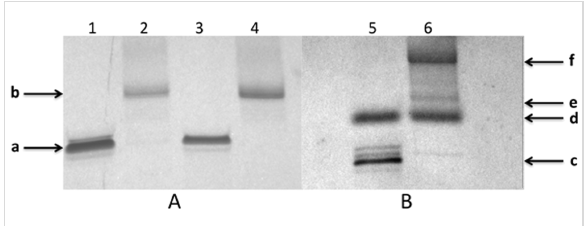
Figure 13: Electrophoresis analysis of samples from reaction mixtures after click reactions between alkyne-TFO and azide-polyamide in denaturing 20% polyacrylamide gel, visualization by UV-shadowing. A) conjugates 23 and 25 : lane 1 – control oligonucleotide 15 , lane 2 – conjugate 23 , lane 3 – control oligonucleotide 17 , lane 4 – conjugate 25 . B, conjugate 24 : lane 5 is control oligonucleotide 16 , lane 6 – conjugate 24 . The arrows indicate positions: a and c – initial alkyne- modified oligonucleotides, b and e – 1:1 conjugates TFO:polyamide, f – 1:2 conjugate TFO-polyamide, d – visible migration marker xylene cyanol.